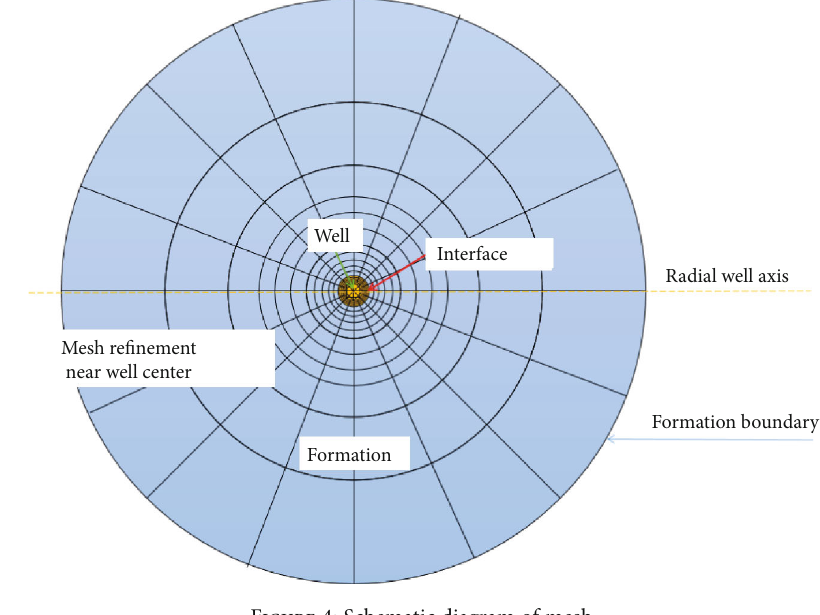
Figure 4: Schematic diagram of mesh.